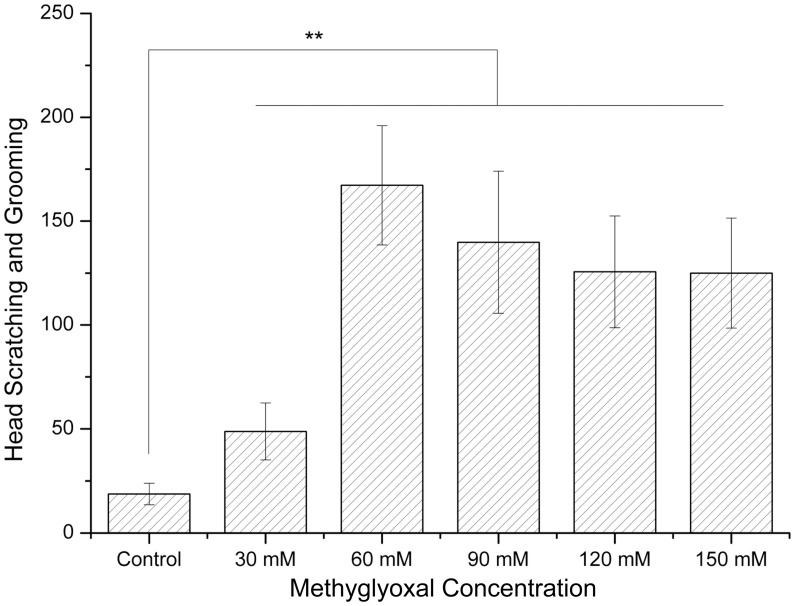
Effects of methylglyoxal on head scratching and grooming behaviors.The time of scratching behavior in all treatment groups markedly increased compared with controls. **p<0.01 versus controls.